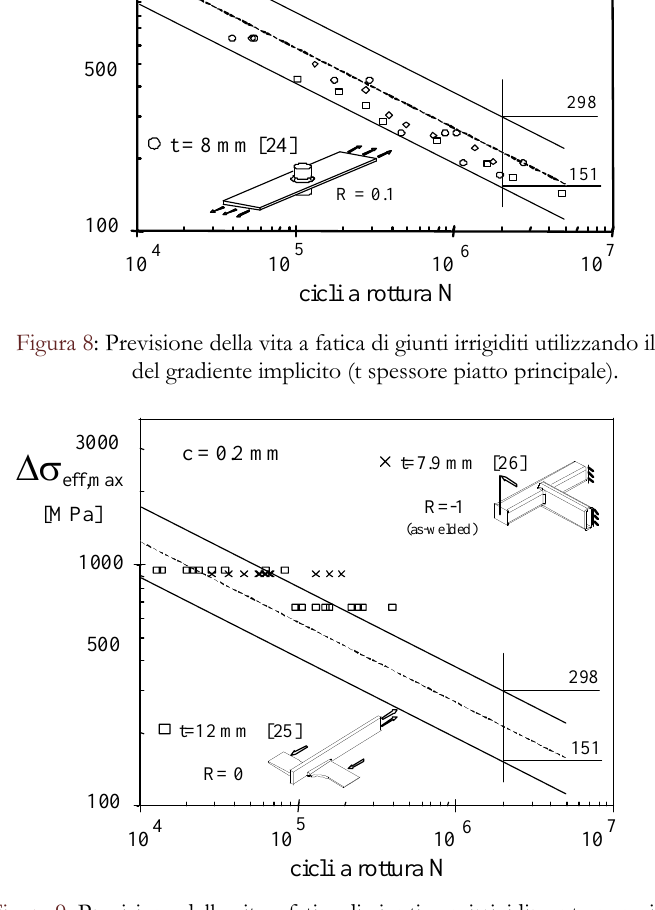
Figura 9: Previsione della vita a fatica di giunti con irrigidimento non simmetrico e di giunti ottenuti con profili tubolari (t spessore piatto